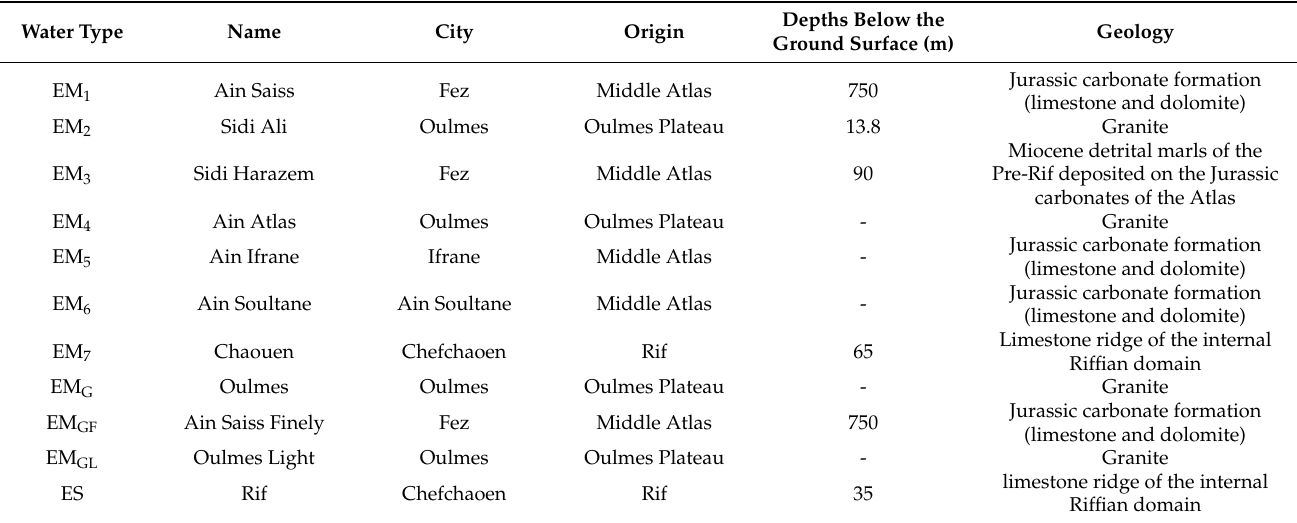
Table 1. Types of bottled water studied.